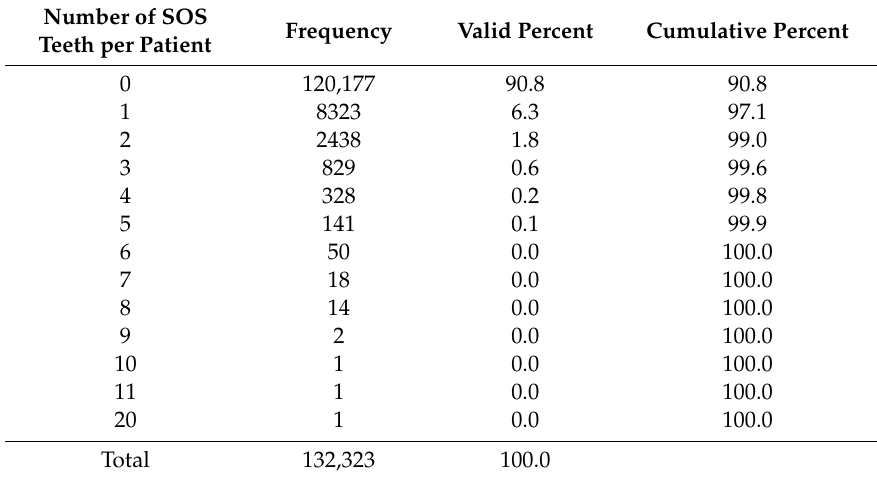
Table 2. Distribution of the number of SOS teeth per patient among the study population.